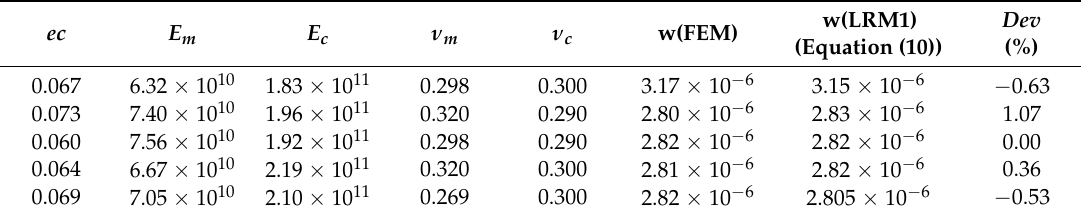
Table 11. Verification of statistic model LRM1 (case study 1, thinner core).